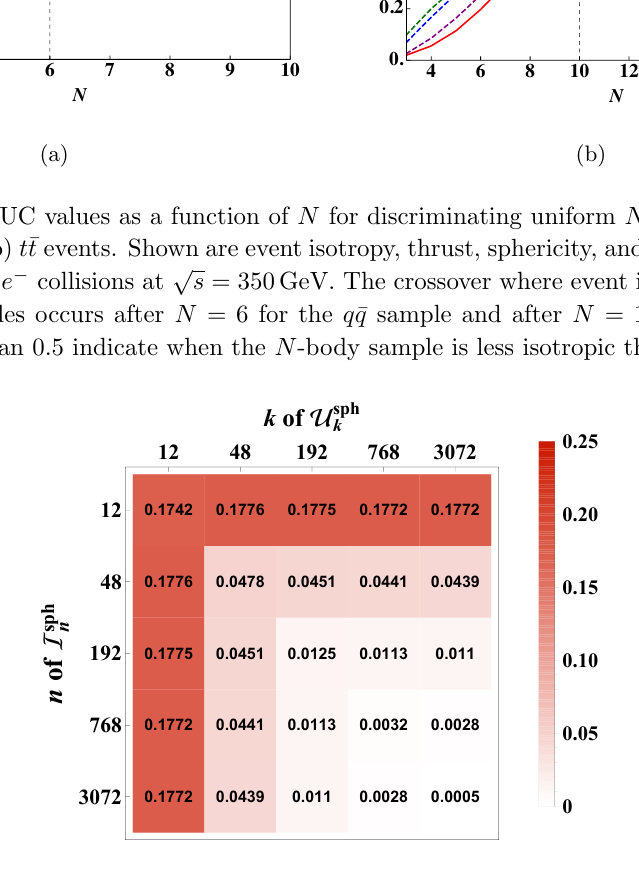
for a k -particle sphere, averaged over random n